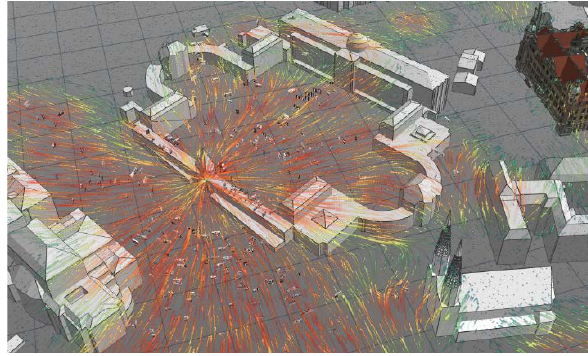
Figure 8. Flow visualizing popular angles for